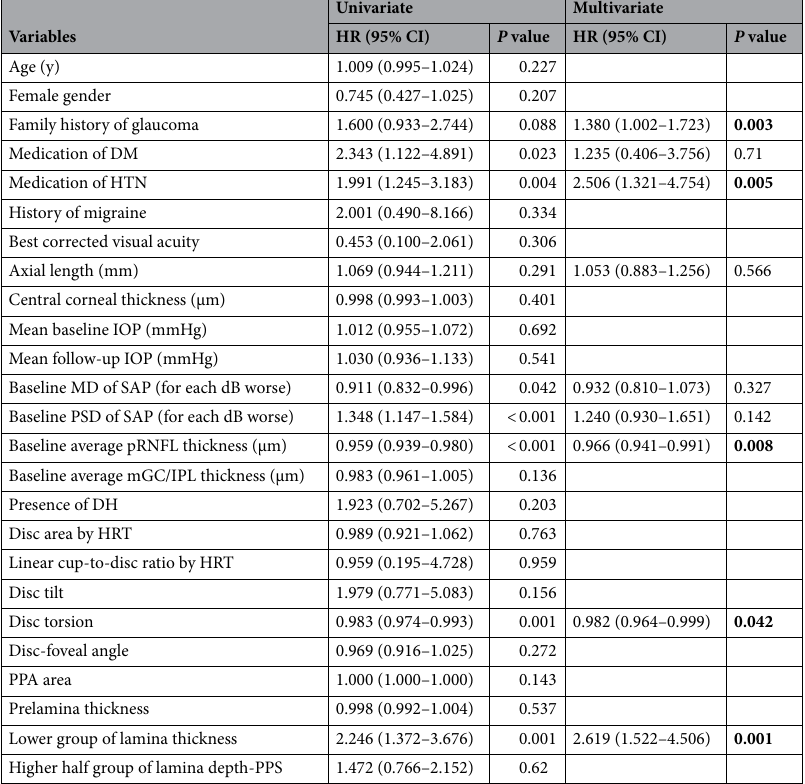
Table 3. Factors associated with progression to NTG in NTG suspect patients. HR hazard ratio; CI, confidence interval; DM, diabetes mellitus; HTN, systemic hypertension; pRNFL, peripapillary retinal nerve fiber layer; mGC-IPL, macular ganglion cell-inner plexiform layer; IOP, intraocular pressure; MD, mean deviation; PSD, pattern standard deviation; dB, decibel; MD, mean deviation; SAP, standard automated perimetry; DH, disc hemorrhage; HRT, Heidelberg retinal tomograph; PPA, peripapillary atrophy; PPS, peripapillary sclera. Factors with P < 0.1 in univariate analysis were included in multivariate analysis. Data are mean ± standard deviation unless otherwise indicated. Factors with statistical significance are shown in